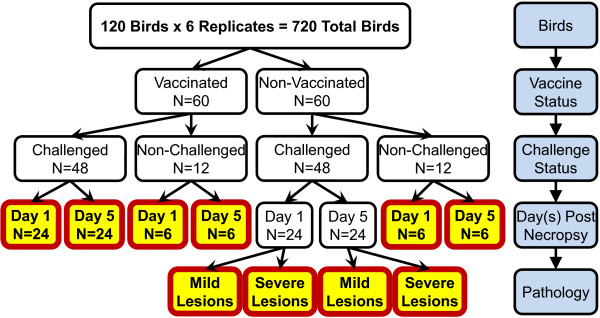
Experimental design. Flow chart of experimental design and 10 treatment groups showing how bird numbers within each replicate were placed into each of the 10 treatment groups.